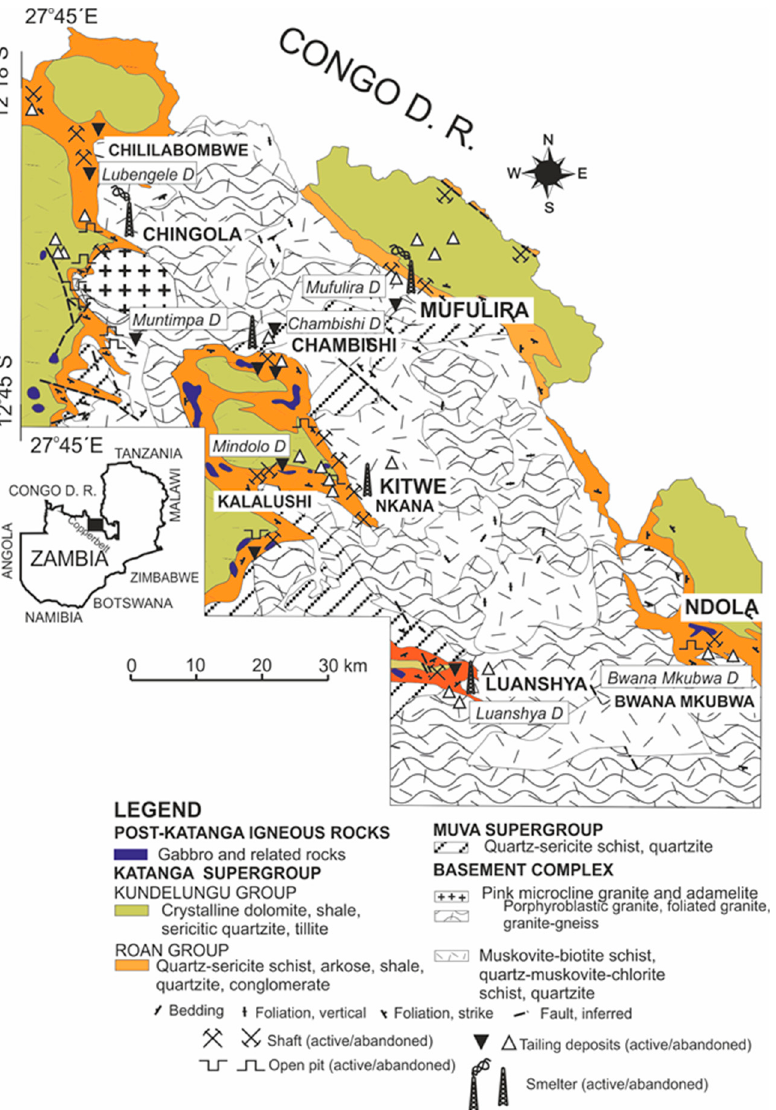
Figure 1. Geological sketch map of the surveyed part of the Copperbelt Province in Zambia. Compiled and simplified after Garrard [63], Marjonen [61], and Mukwila [64] with the location of major sources of contamination (smelters and tailing impoundments).